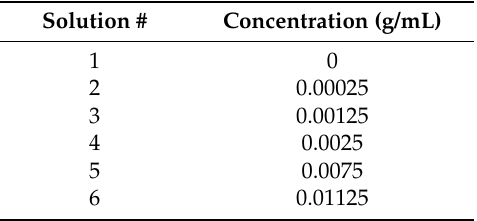
Table 2. Lithium carbonate